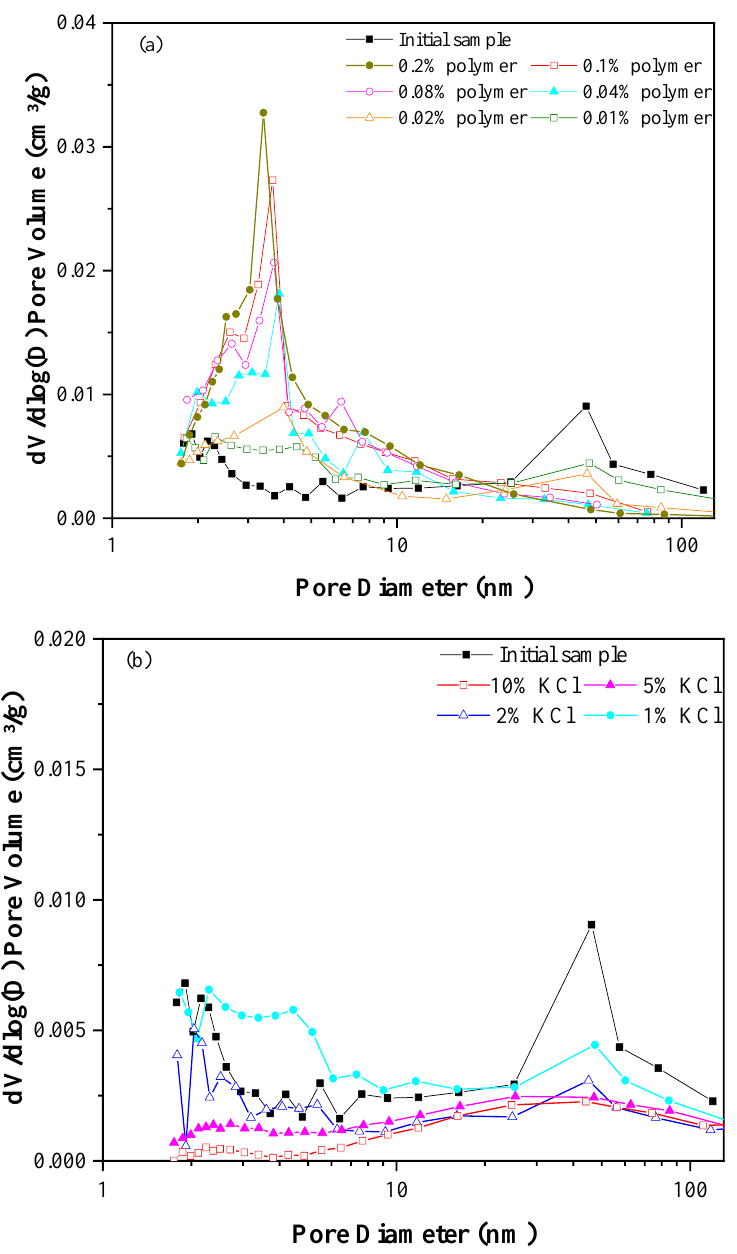
Figure 4. Pore throat distribution of tight sandstone: ( a ) polymer and ( b ) KCl.